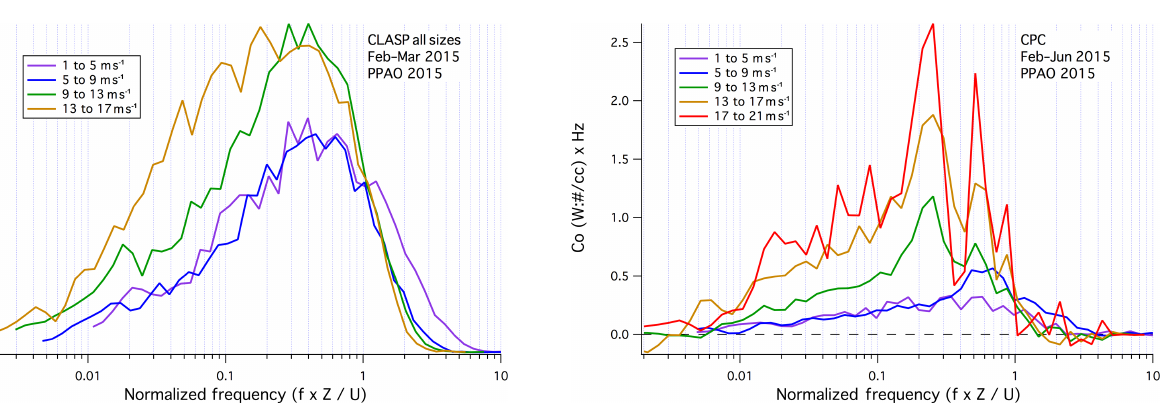
Figure 1. Averaged CLASP frequency-weighted total (net) aerosol number cospectra in wind speed bins for the southwest (open water) wind direction.